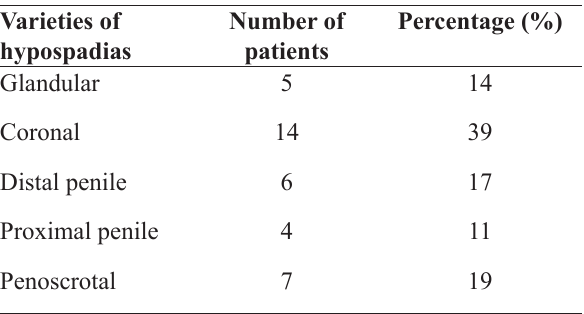
Table 2. (cid:55)(cid:68)(cid:69)(cid:79)(cid:72)(cid:3) (cid:71)(cid:72)(cid:83)(cid:76)(cid:70)(cid:87)(cid:76)(cid:81)(cid:74)(cid:3) (cid:87)(cid:75)(cid:72)(cid:3) (cid:71)(cid:76)(cid:3445)(cid:72)(cid:85)(cid:72)(cid:81)(cid:87)(cid:3) (cid:89)(cid:68)(cid:85)(cid:76)(cid:72)(cid:87)(cid:76)(cid:72)(cid:86)(cid:3) (cid:82)(cid:73)(cid:3) hypospadias (n=36) Varieties of